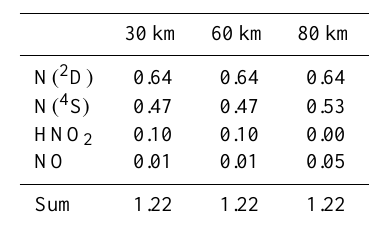
Table 3. NO y P/Q net production numbers for January, NH, Q = 100cm − 3 s − 1